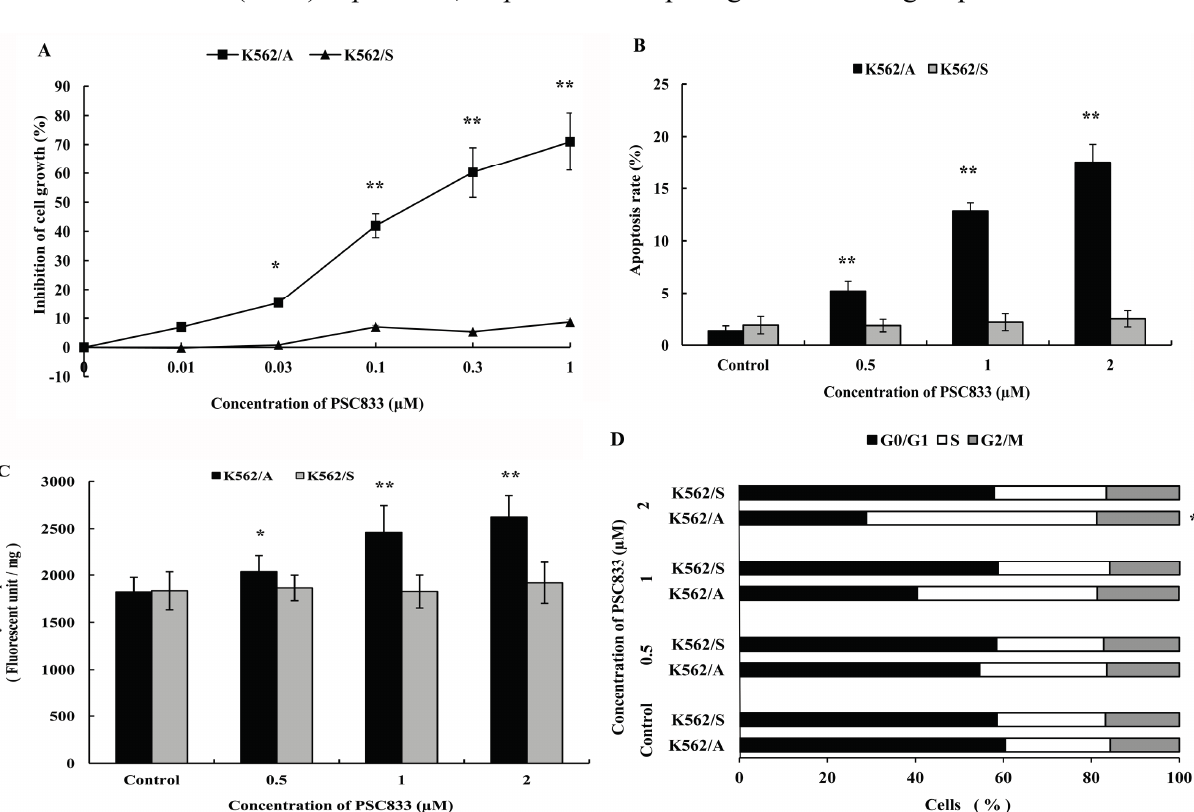
Figure 4. Effect of PSC833 on viability and induction of apoptosis in K562/A and